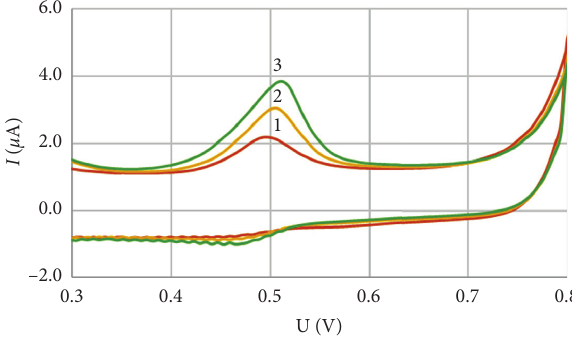
Figure 2: Cyclic voltammograms of 0.1 mg l − 1 Hg 2+ in